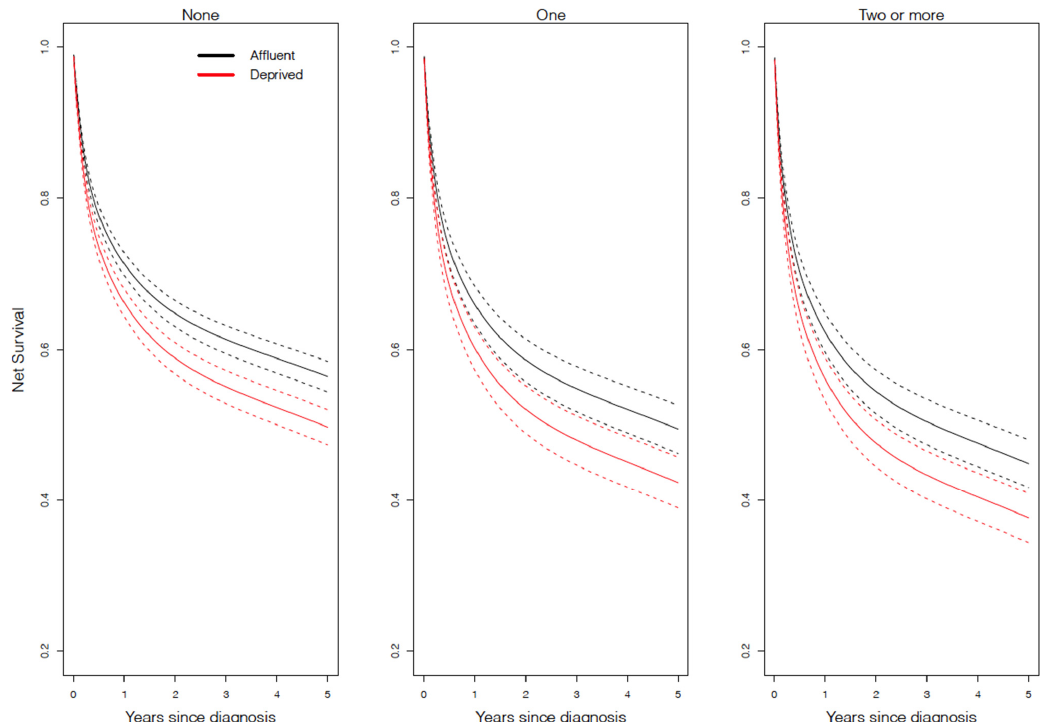
Figure 3. Net survival model-based prediction for diffuse large B-cell lymphoma for each comorbidity status by deprivation level ( n = 29,898) in England between 2005 and 2013. The values here are presented for 70-year-old white males diagnosed via a general practitioner referral. Values will change for other covariates, but the pattern observed here will remain.